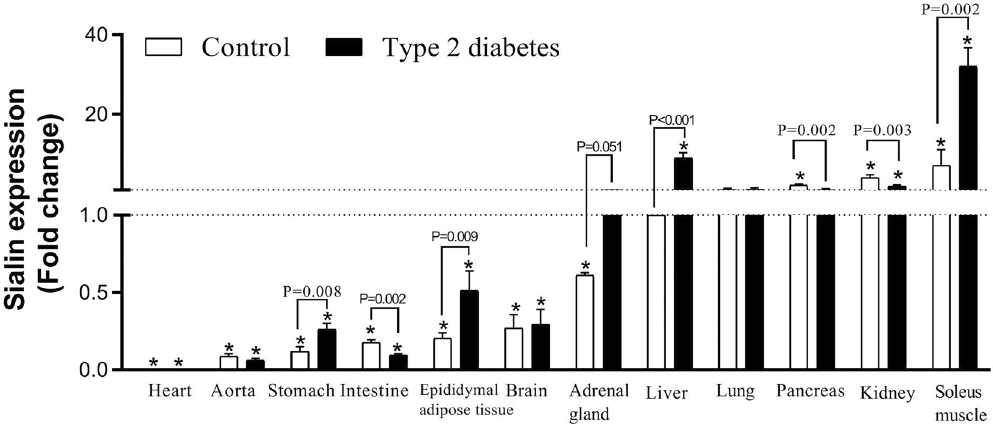
Figure 3. Changes in mRNA expression of sialin in control and type 2 diabetic rats. *Significant difference compared to the liver tissue of control rats, which its expression was considered as